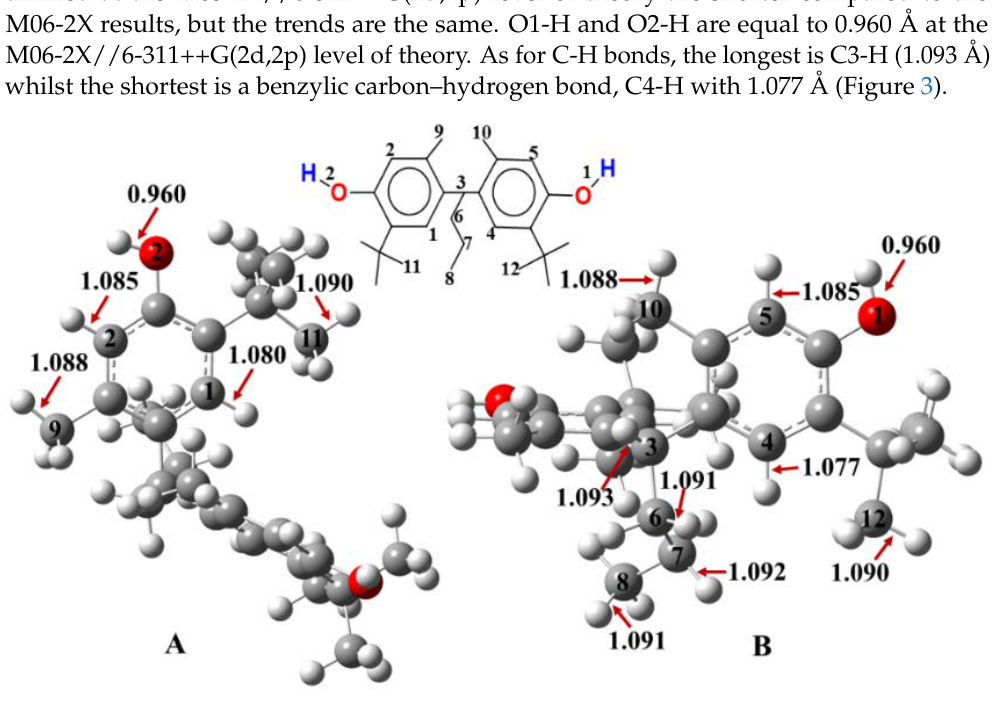
Figure 3. 2D and 3D structures of the studied synthetic antioxidant additive, Santowhite. ( A , B ) are the same 3D structure from different points of view. Geometry optimizations have been carried out at the M06-2X/6-311++G(2d,2p) level of theory in gas phase, and the corresponding bond lengths are also shown in Å.